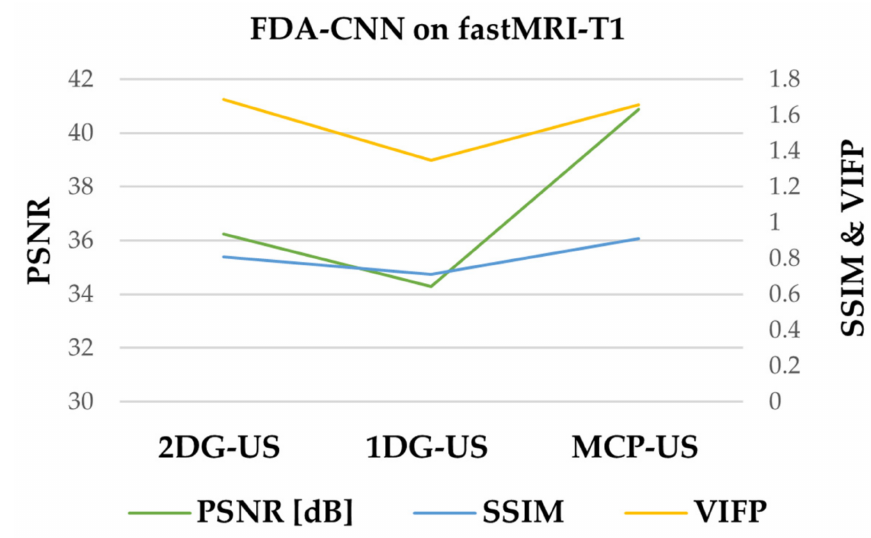
Figure 11. Comparison of three sampling patterns on fastMRI dataset using FDA-CNN.